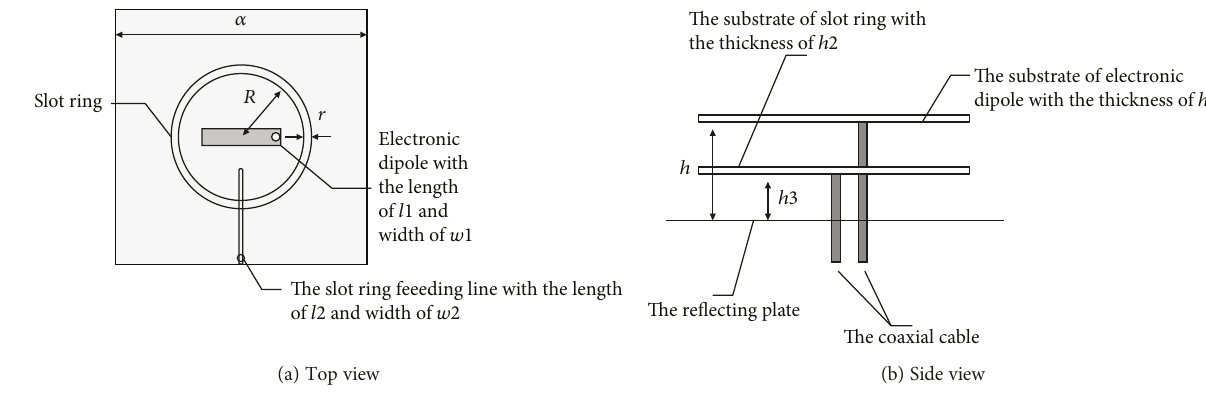
Figure 1: Antenna